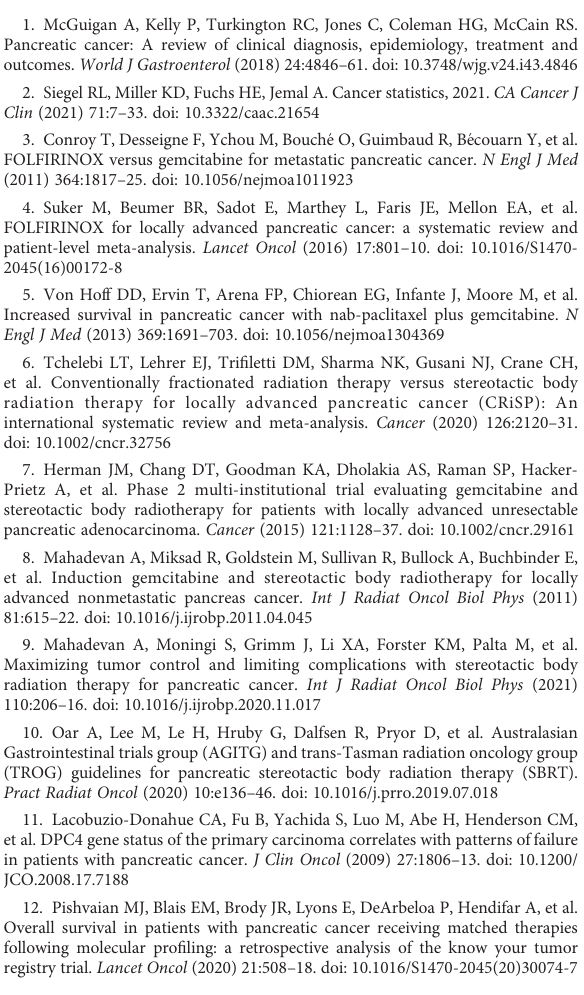
SUPPLEMENTARY FIGURE 1 Kaplan-Meier curves of (A) overall survival, and (B) local progression-free survival according to metastatic status and overall response to the induction chemotherapy. SBRT, stereotactic body radiotherapy. SUPPLEMENTARY FIGURE 2 Comparison of receiver operating characteristic (ROC) curves of dosimetric parameters for predicting the 3-year incidence of local progression. GTV, gross tumor volume; AUC, area under curve.GTV Dmin, the minimum dose absorbed by 1cc of the GTV; GTV Dmax, the maximum dose absorbed by 1cc of the GTV; GTV Dmean, mean dose absorbed by the